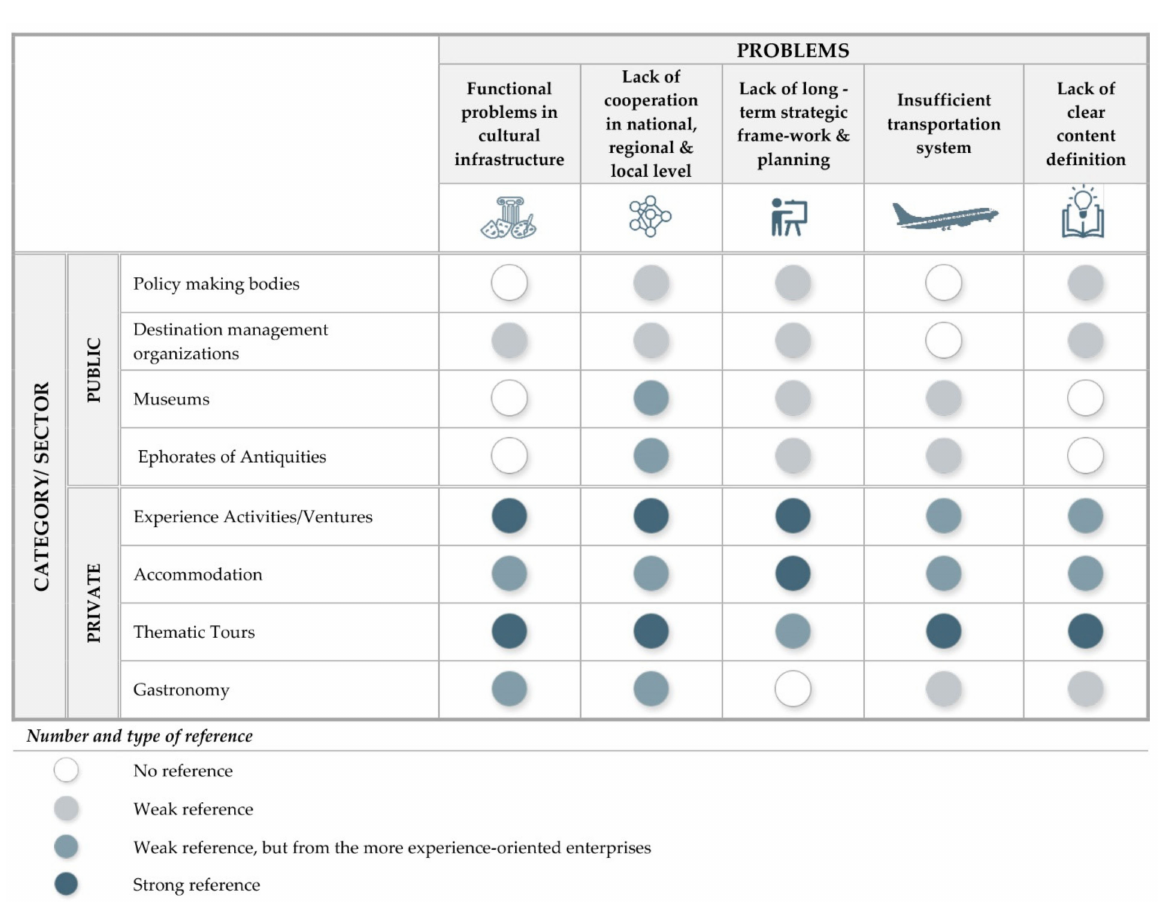
Figure 5. Main problems of experiential tourism in the study